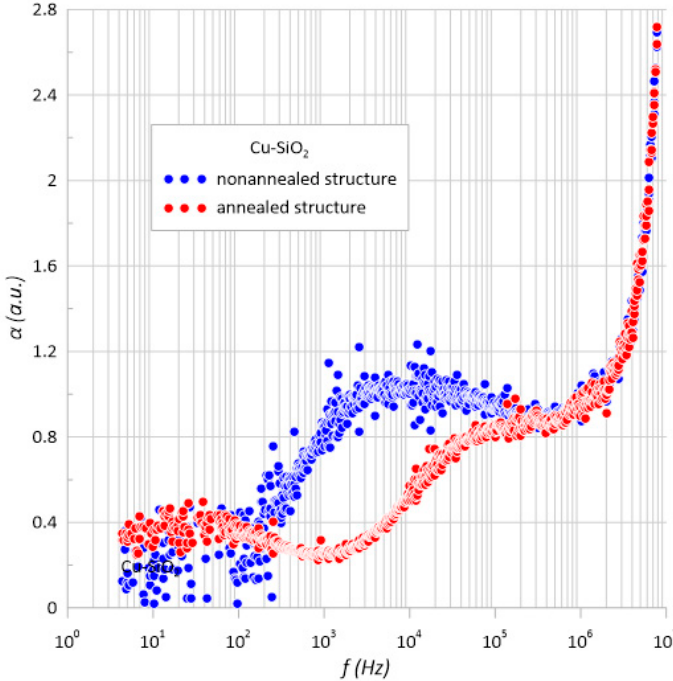
Figure 5. Frequency dependence of the frequency coefficient α of the Cu-SiO 2 nanocomposite measured at room temperature before and after annealing T a = 473 K.